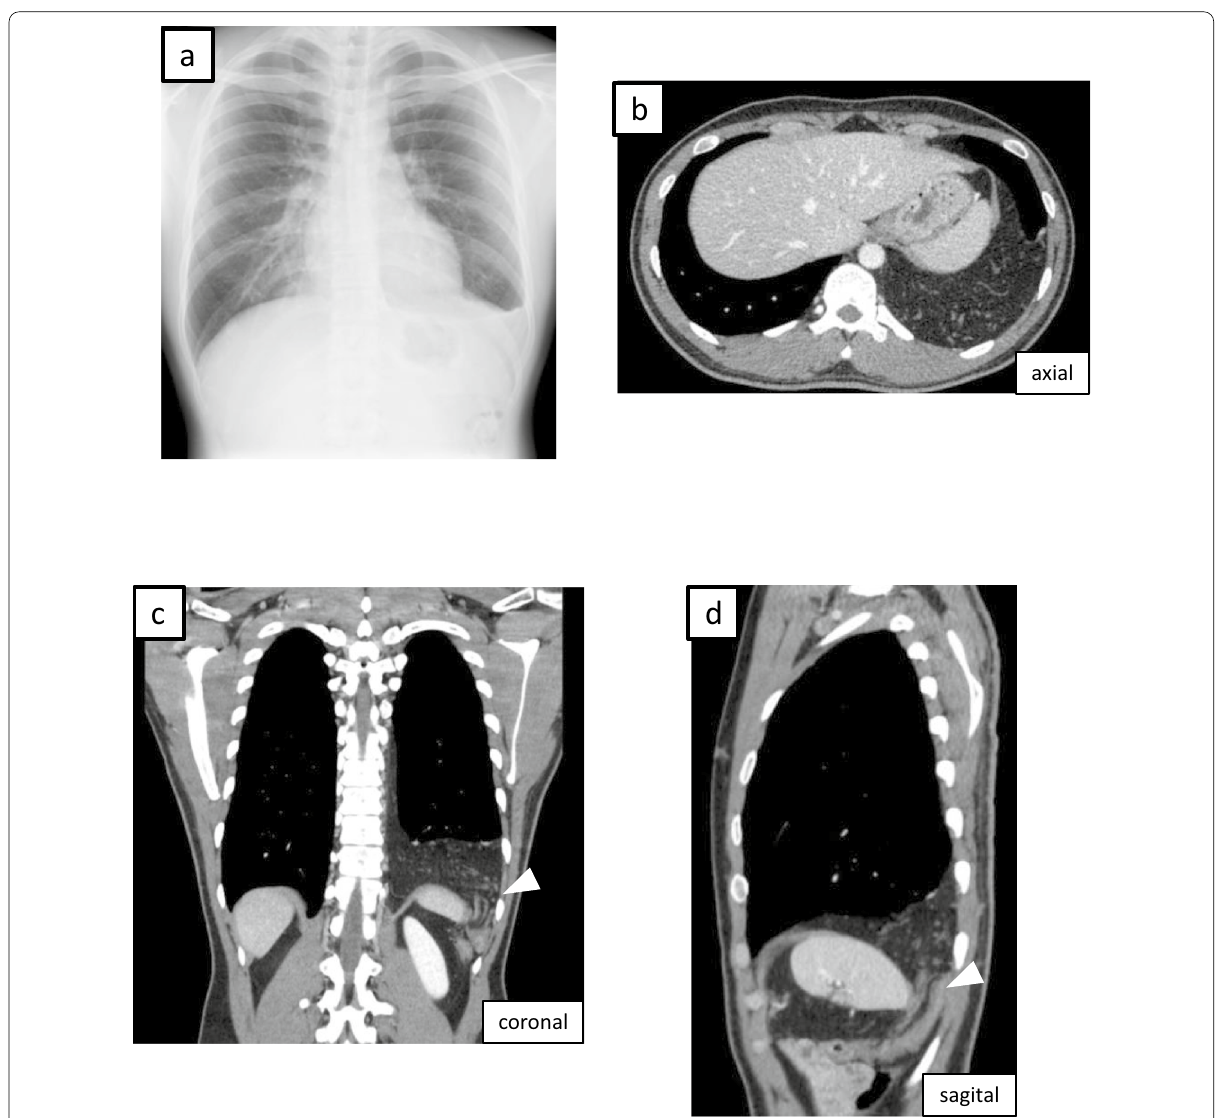
Fig. 1 Preoperative diagnostic imaging. a Chest radiography showing an abnormal shadow of the left diaphragm. b Axial computed tomography (CT) showing herniation of omentum into the left thoracic cavity. Coronal ( c ) and sagittal ( d ) CT showing omental herniation through the orifice (arrowhead) at the posterolateral